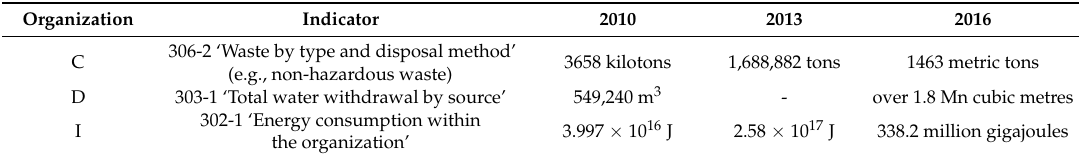
Table 7. Differences in terms of the used measurement